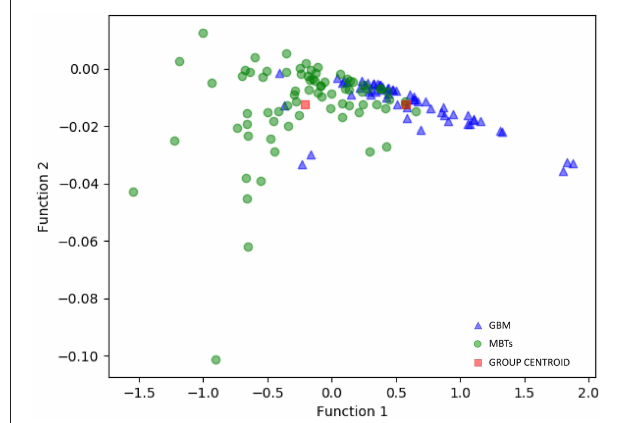
FIGURE 4 | Distribution of the discriminant functions of LDA in discriminating GBM from MBTs.